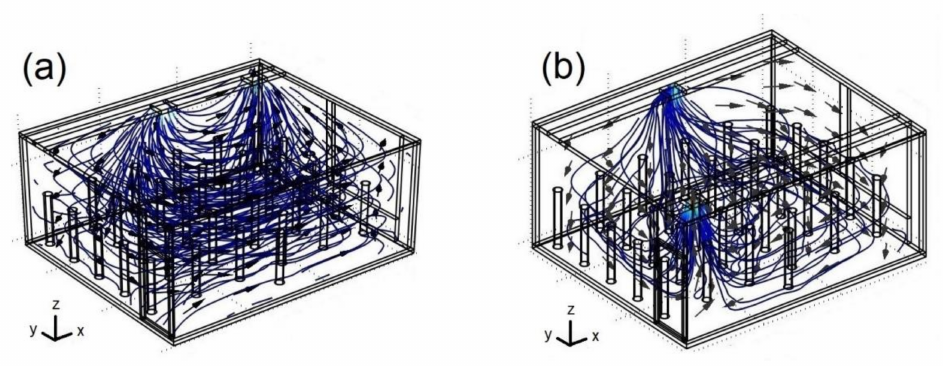
Figure 5. Velocity fields for: ( a ) case III; ( b ) case VI. Re = 15,000, 3:30 p.m. and C s = 37,500